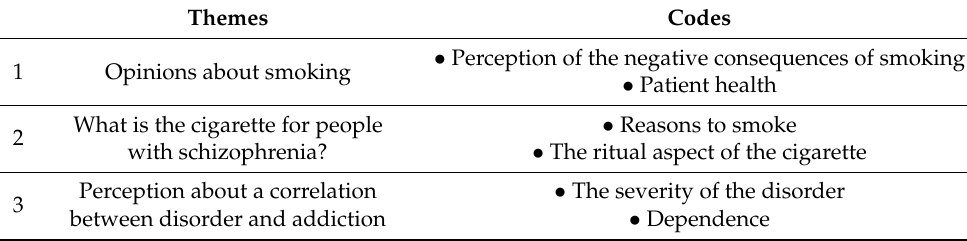
Table 3. Themes and